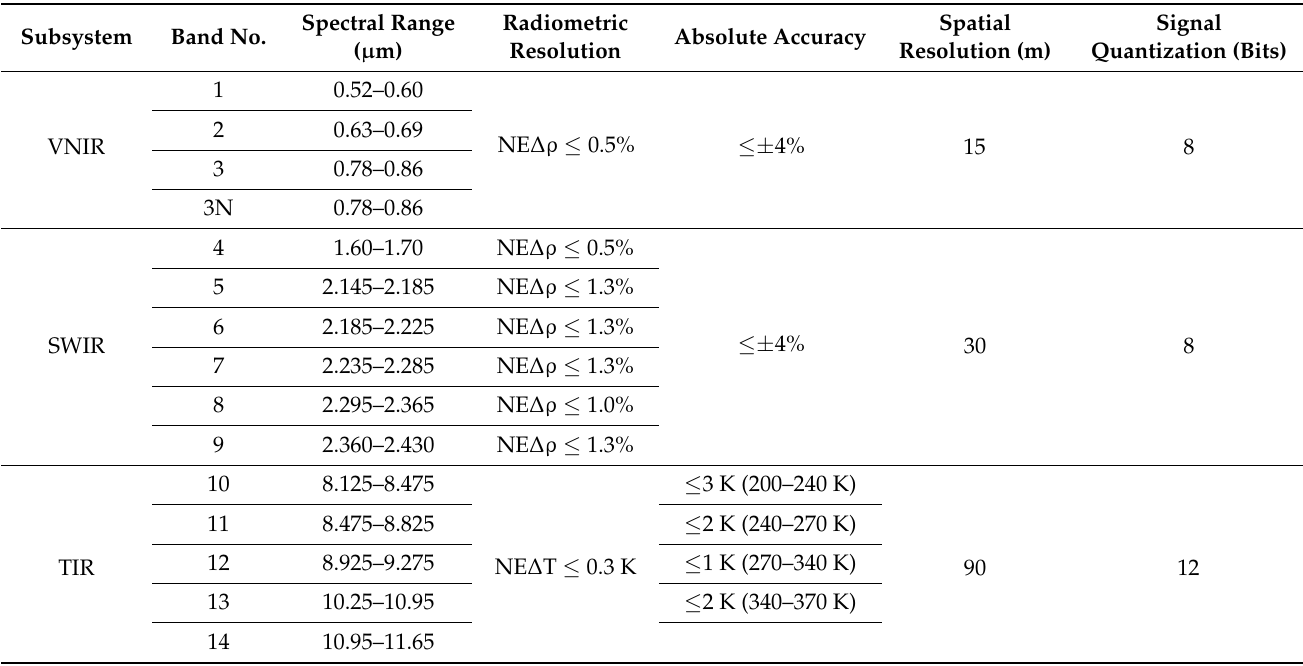
Table 2. Characteristics and performance of the ASTER sensor